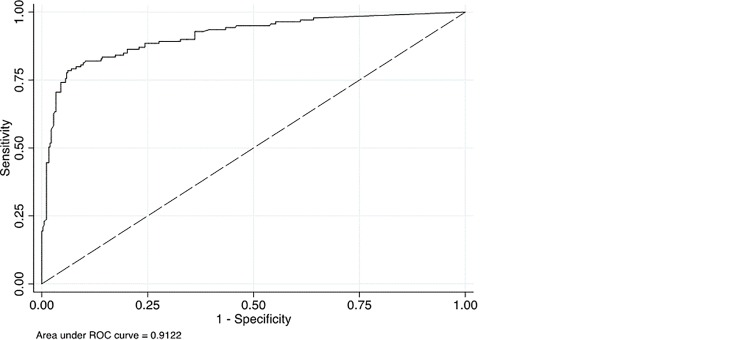
Receiver Operating Characteristics Curve for VFA compared to Cobas-Ampliprep.NB: AUC–Area under curve denotes the area in the graph below Receiver Operating Characteristic (ROC) curve, comparing the true positive to the true negative values. The true positive rate (sensitivity) is plotted in function of the false positive rate (100 –specificity) for different cut–off points. Each point on the ROC curve represents a sensitivity/specificity pair corresponding to a particular decision threshold. A test with perfect discrimination (no overlap in the two distributions) has a ROC curve that passes through the upper left corner (100% sensitivity, 100% specificity). Therefore the closer the ROC curve is to the upper left corner, the higher the overall accuracy of the test. An area of 1 represents a perfect test whilst 0.5 is a worthless test.